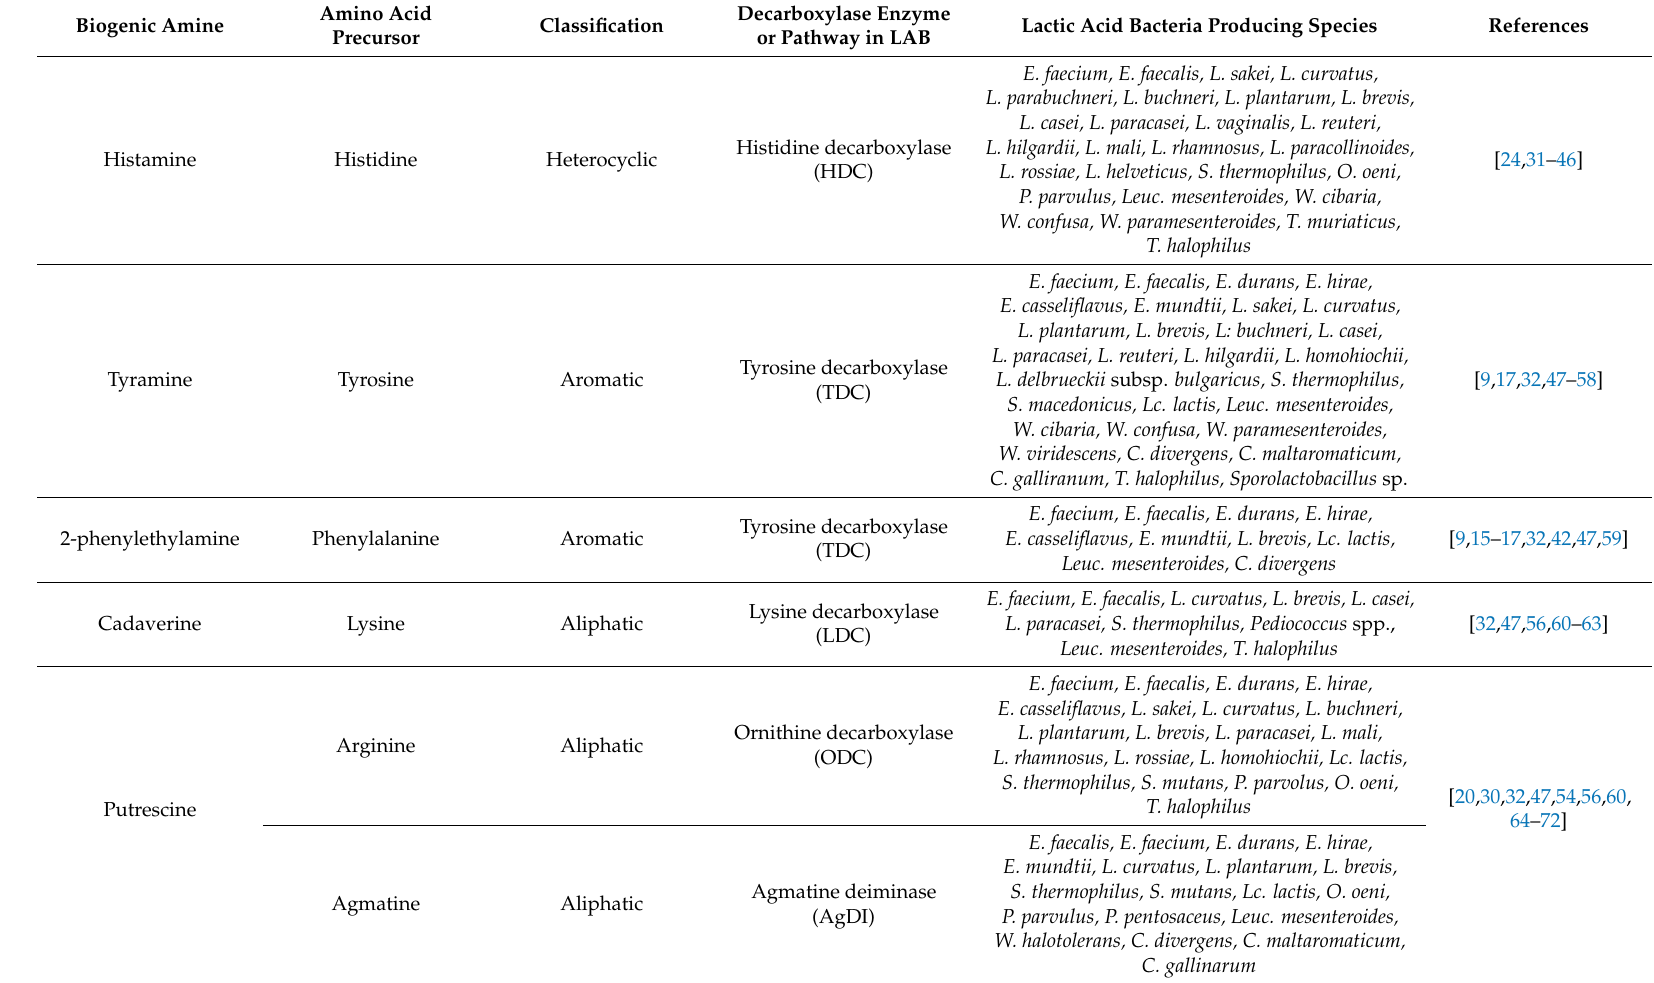
Table 1. Biogenic amines, precursors, decarboxylase enzyme and their producers lactic acid bacteria found in fermented